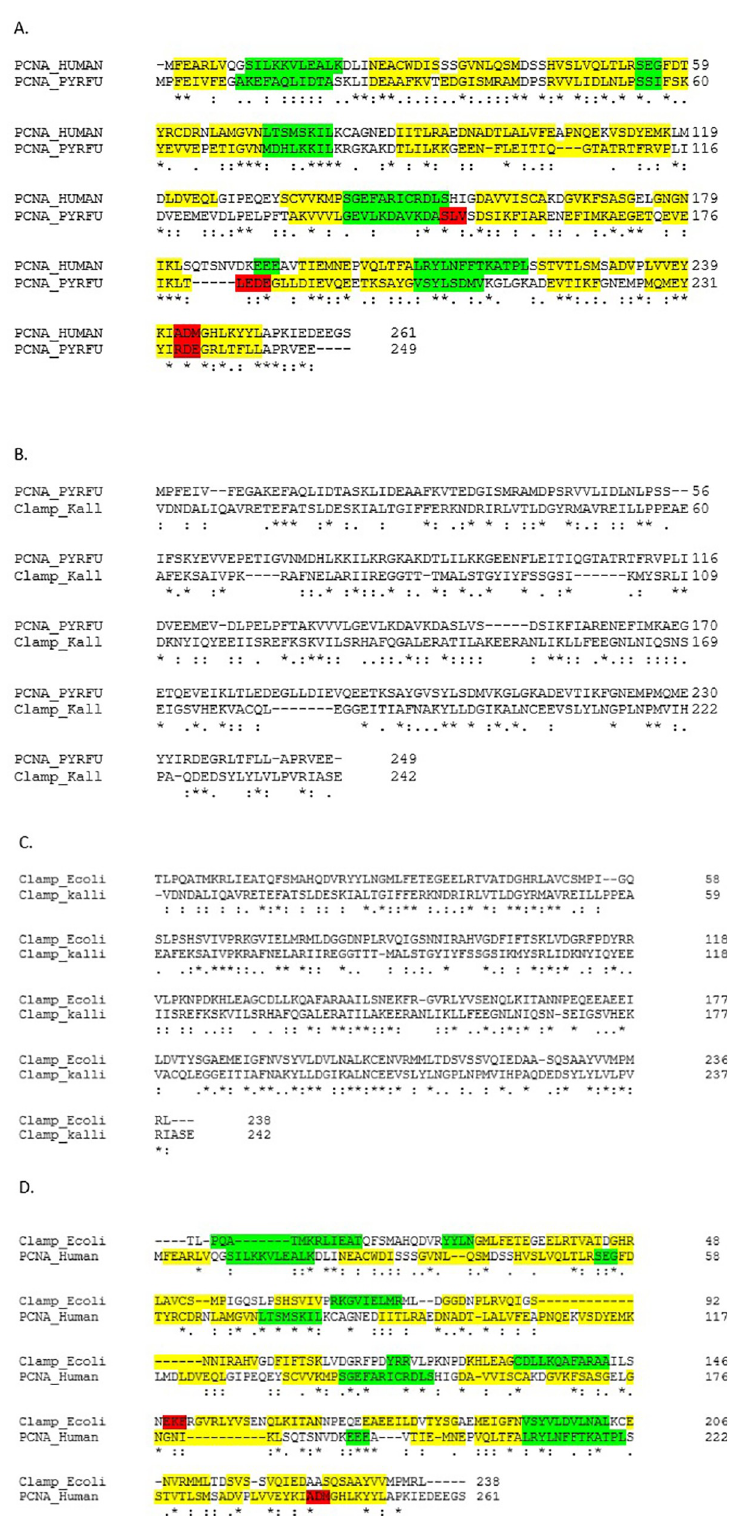
Fig 2. Clustal omega alignment of (A) Human and P . furiosus PCNAs (B) P . furiosus PCNA and K . gabonensis beta clamp (C) E . coli beta clamp and K . gabonensis beta clamp (D) E coli beta clamp and human PCNA. When PCNA and beta clamps were aligned, domain 1 of PCNA was aligned to domain 2 of beta clamp and domain 2 of PCNA was aligned to domain 3 of beta clamp. Since (A) and (C) align PCNA to PCNA and beta clamp to beta clamp (domains 2 and 3 aligned), they show the highest degree of similarity and identity. (B) P . furiosus PCNA and K . gabonensis beta